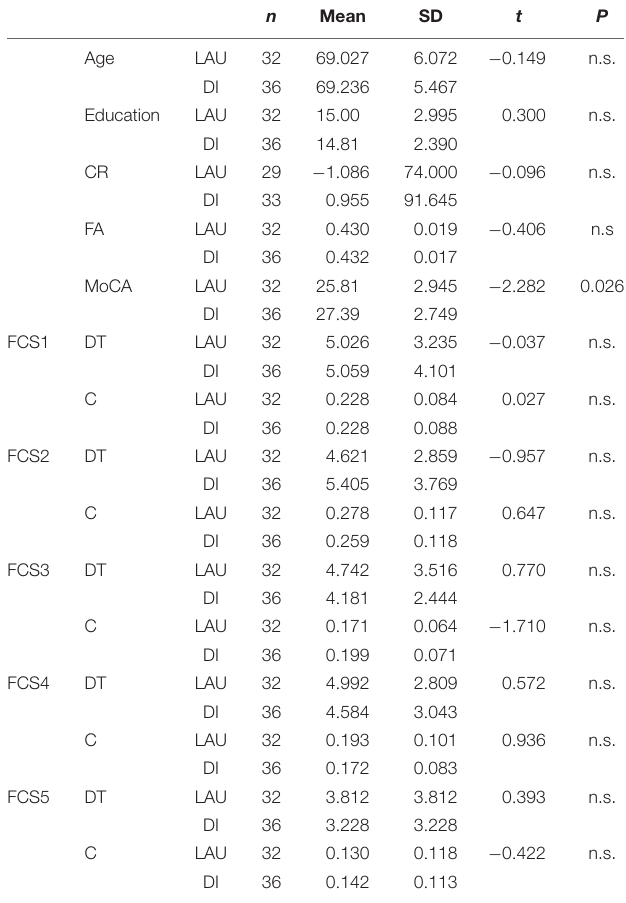
(LAU) groups at the baseline